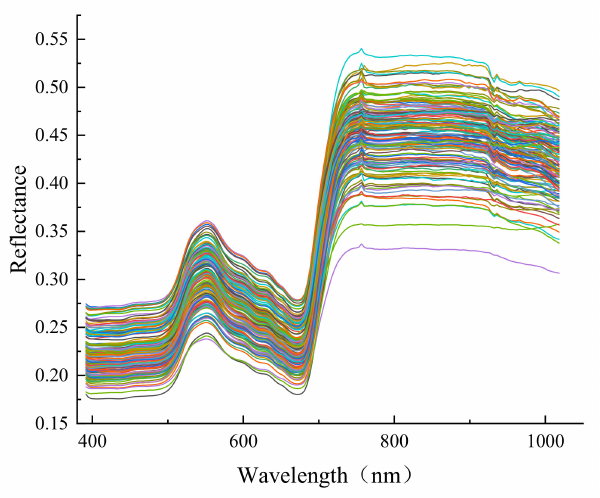
Figure 5. Outdoor hyperspectral raw